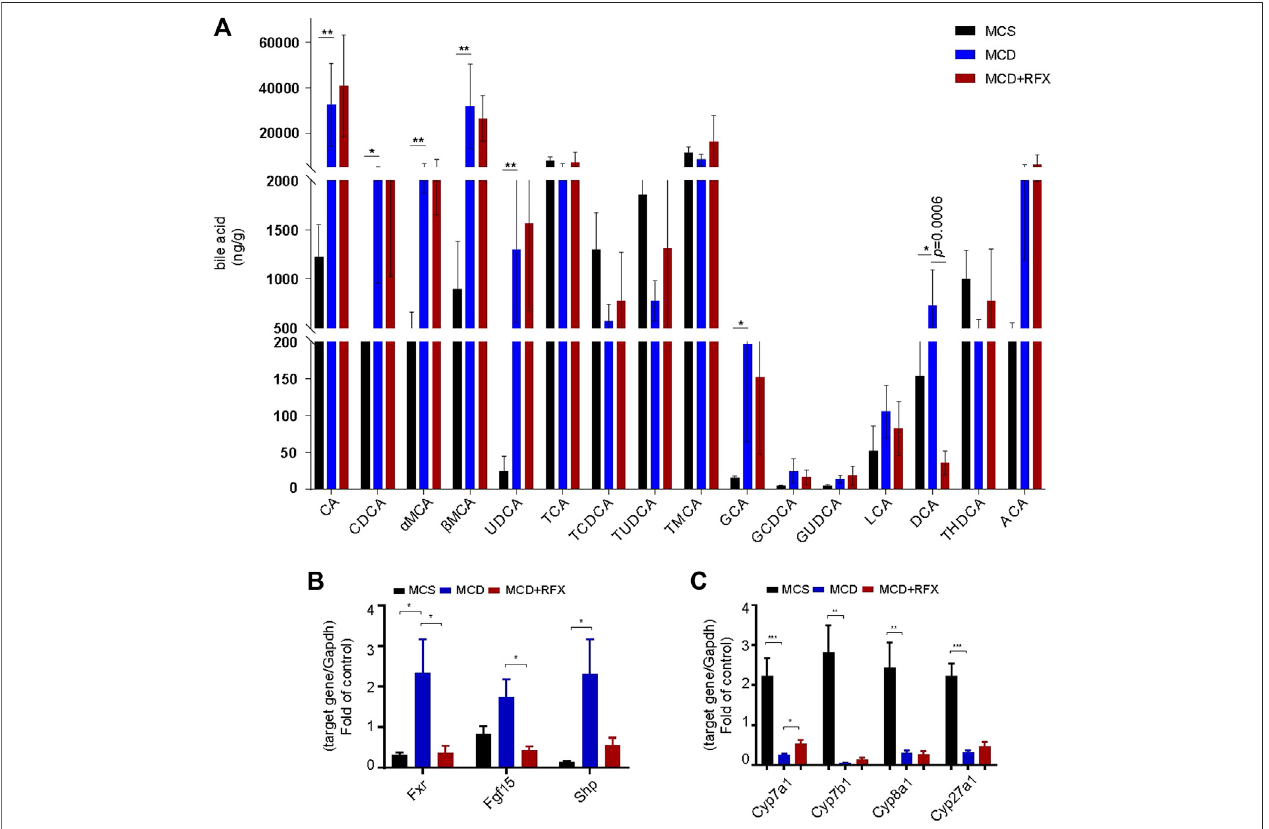
FIGURE 5 | Impact of rifaximin on bile acid levels in the ileum and on the FXR signaling pathway. (A) Bile acid levels in the distal ileum. Levels of DCA decreased signi fi cantlyafter rifaximin treatment inMCD-fedmice n =7mice in each group. (B) Relative expression ofFxr and its target genesFgf15and Shpinthe mouse intestine. (C) Relative expression of Cyp7a1, Cyp7b1, Cyp8b1, and Cyp27a1 mRNAs. Gapdh is for normalization. * p < 0.05, ** p < 0.01, *** p < 0.001 (Kruskal-Wallis test). n = 8 mice in each